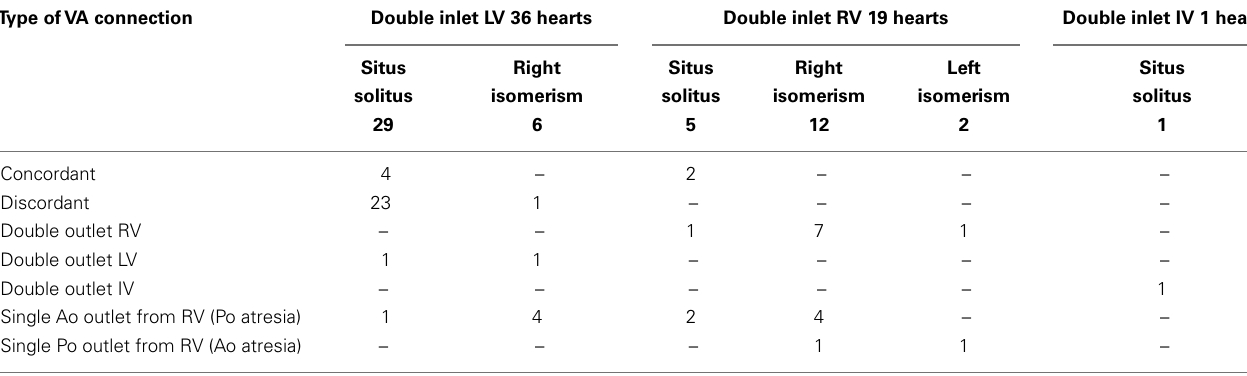
Table 3 | Double inlet ventricles: type ofVA connection